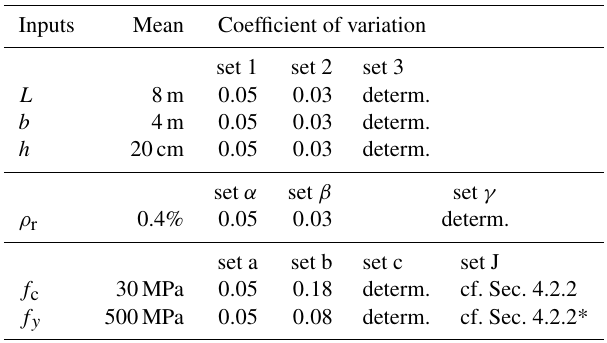
Table 3. Marginal distributions of input parameters. “determ.” means deterministic, which corresponds to a coefficient of variation (COV) equal to zero. In the case of independent variables, normal distributions are used ( ∗ mean of f y is 560MPa for set J). Inputs